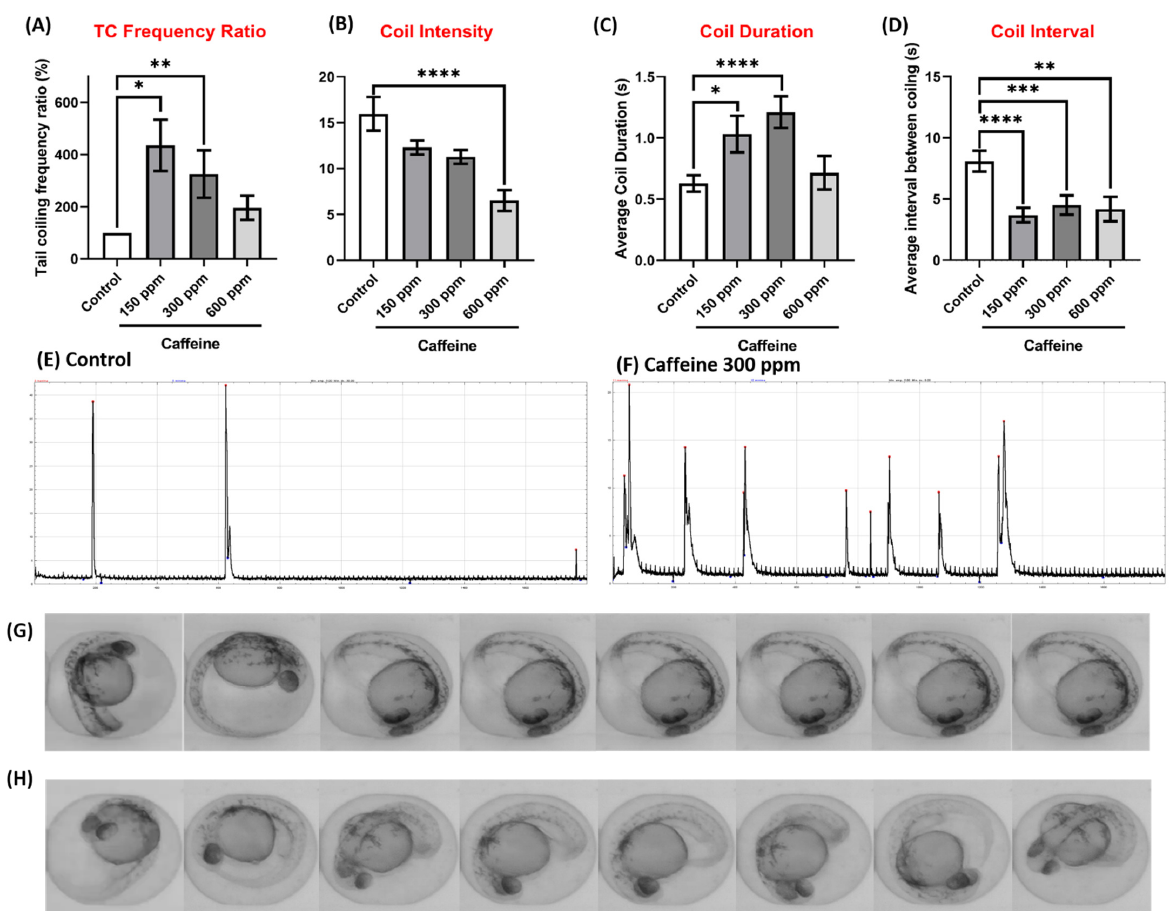
Figure 8. Comparison of tail coiling activity for zebrafish embryos at 24 hpf for control and caffeine exposure. ( A ) Quanti- tative comparison of tail coiling frequency ratio, ( B ) average intensity, ( C ) coil duration and ( D ) coil interval of zebrafish embryos treated with different doses of caffeine. The representative tail coiling peak obtained from either ( E ) control or ( F ) 300 ppm caffeine exposed zebrafish. Time-lapse comparison showing tail coiling movement in zebrafish embryo after receiving either ( G ) 0 or ( H ) 300 ppm caffeine. Statistical validation is carried out using Kruskal-Wallis test. Data are presented as Mean ± SEM, n = 40 (* p < 0.05, ** p < 0.01, *** p < 0.001, **** p < 0.0001, ns p >